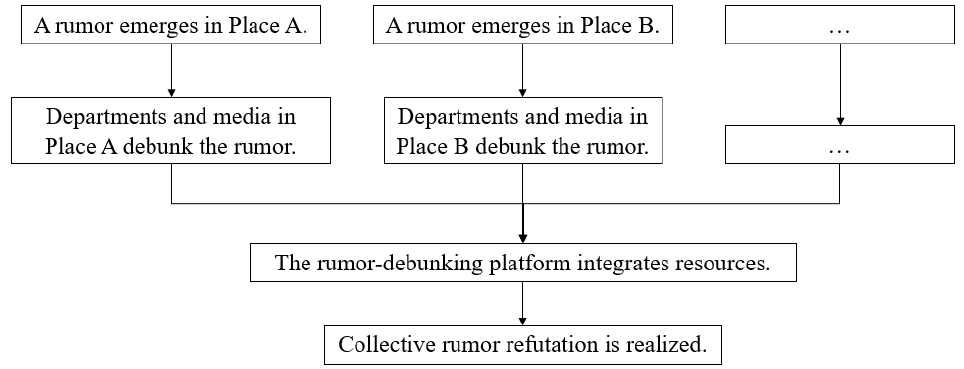
Figure 4. The “ rumor-debunking platform- led” rumor -debunking model. Figure 4. The “rumor-debunking platform-led” rumor-debunking